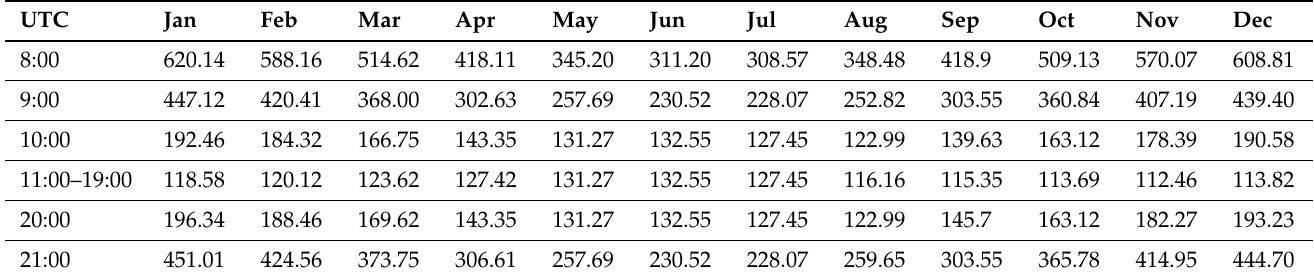
Table 2. CMC thresholds for estimating the number of sprites. The unit is C · km.